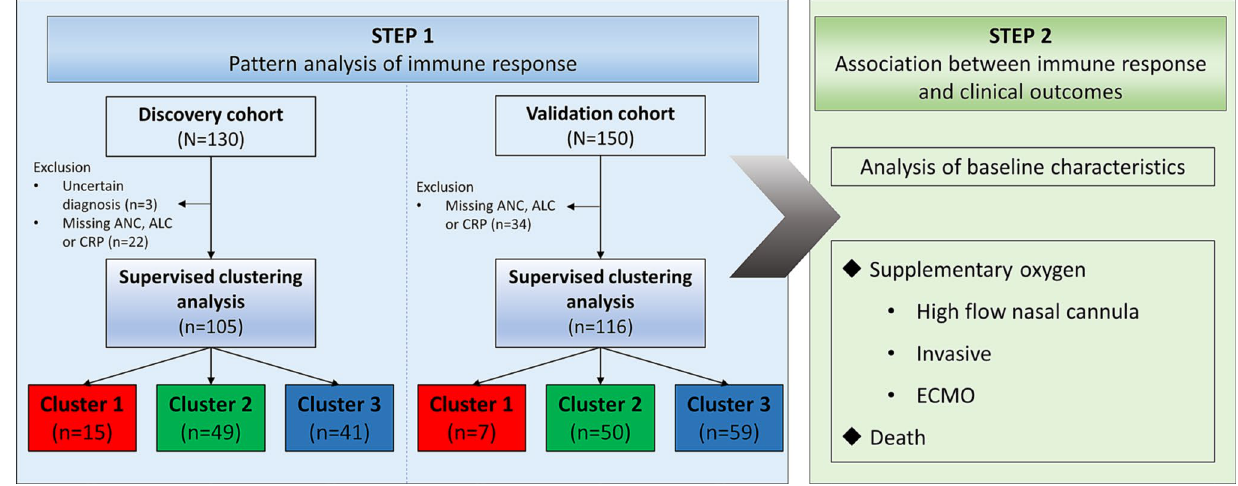
Figure 1. Study design and patient flow. ALC absolute lymphocyte count, ANC absolute neutrophil count, CRP C-reactive protein, ECMO extracorporeal membrane oxygenation, MV mechanical